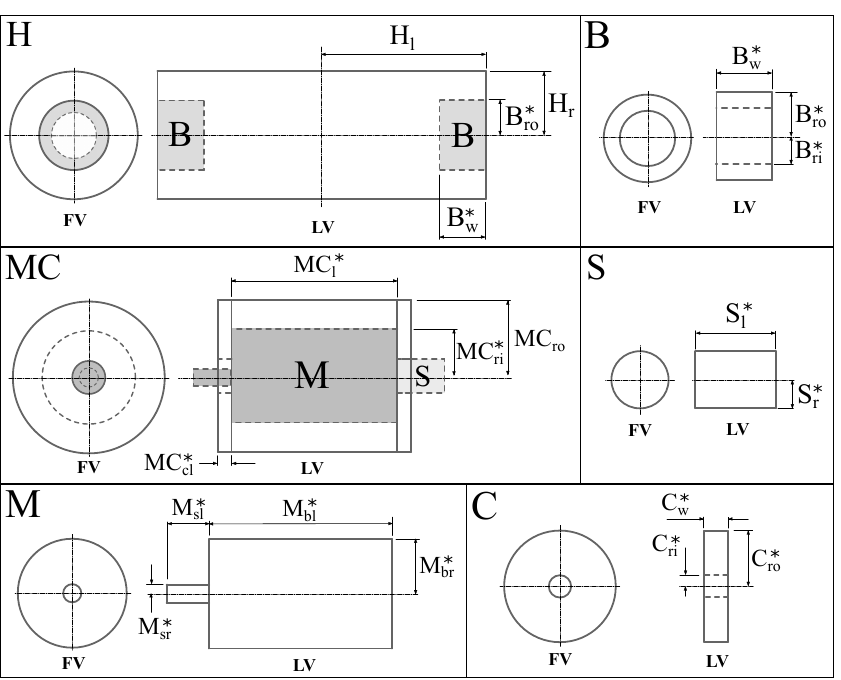
Figure 5. Structural element parametrization. The label * is assigned for constant geometric values. Additionally, the notation FV = Frontal View and LV = Lateral View is considered. Table 1. Constant parameters of structural